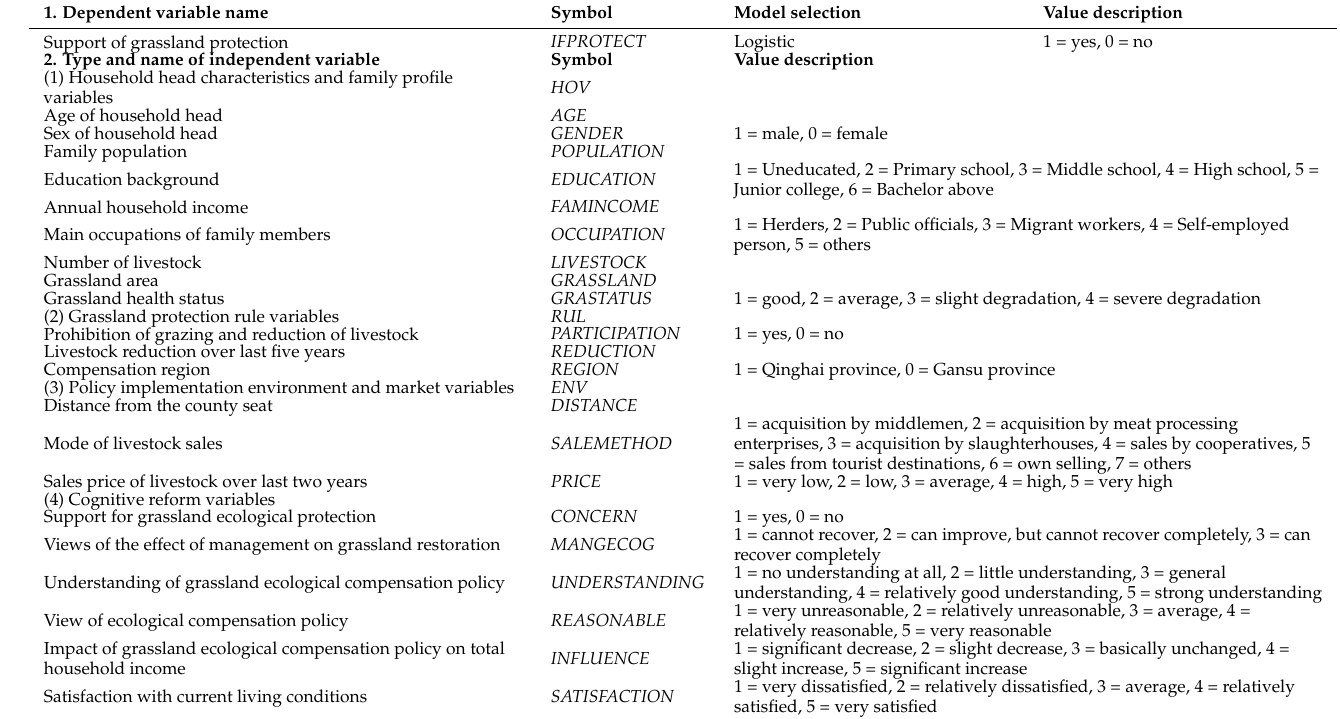
Table 1. Analysis of herders’ willingness to protect